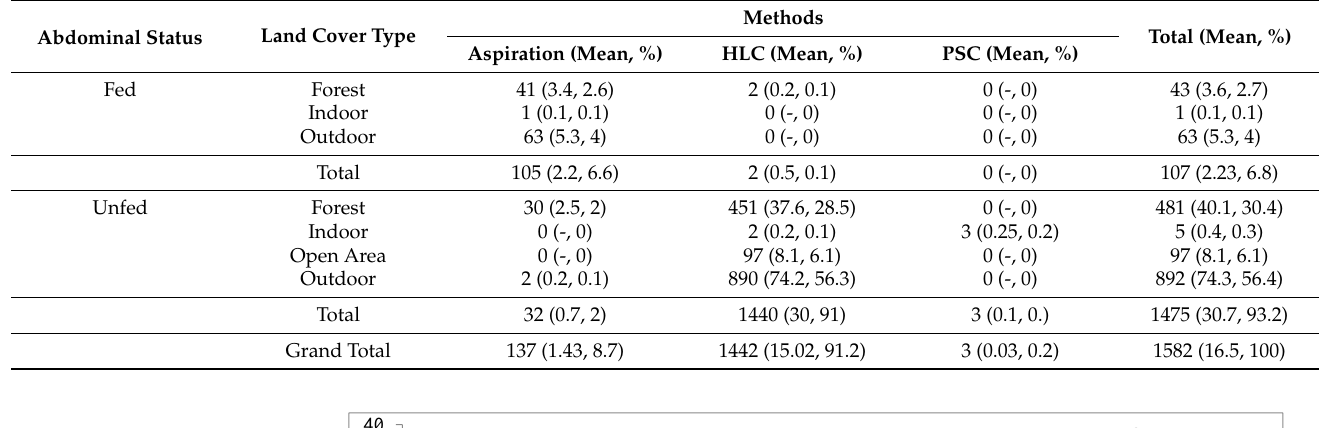
Seasons Wet Dry